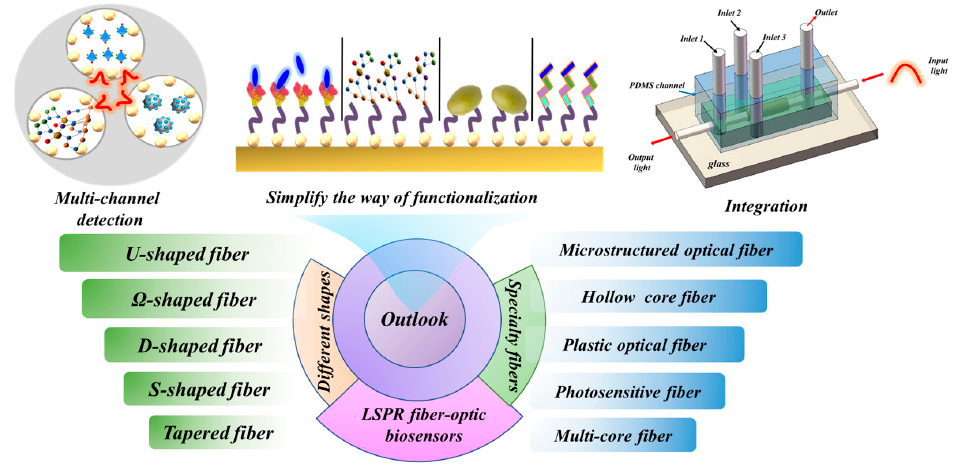
Figure 19. The outlook of LSPR fiber-optic biosensors.